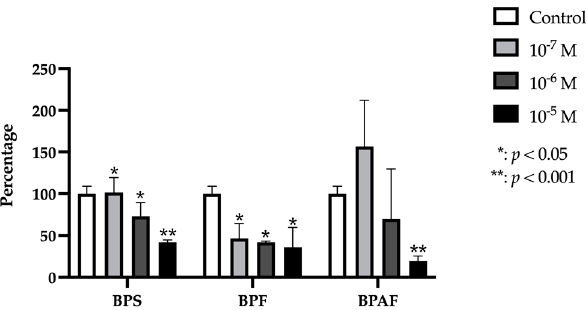
Figure 4. Expression of ALP in primary human osteoblasts treated for 24 h with bisphenol S, F, and AF (10 − 7 , 10 − 6 , or 10 − 5 M). The assay was performed in triplicate with each of the three primary human osteoblast cell lines. Data are expressed as percentage expression with respect to control ± standard deviation. Significant differences * p < 0.05; ** p < 0.001.